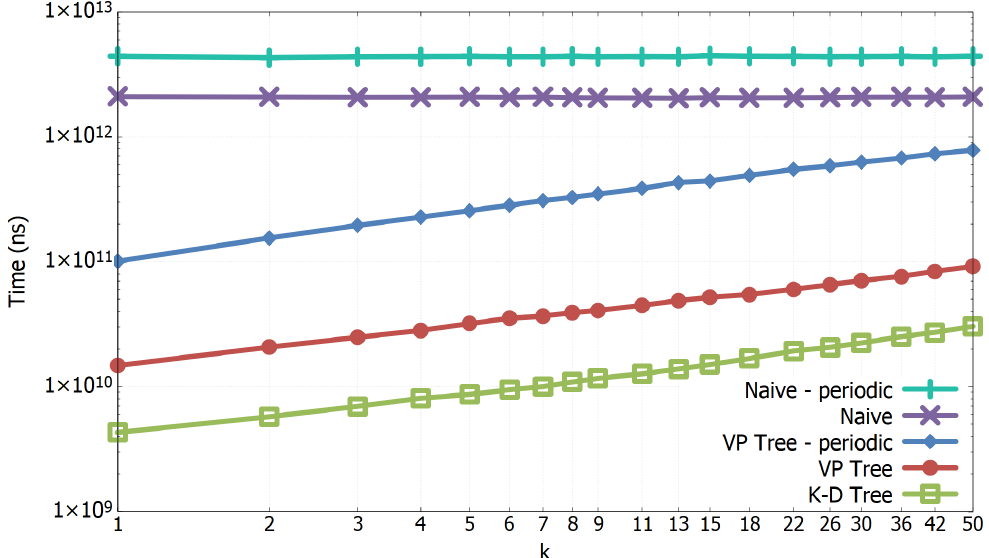
Figure 2. Computational times comparison of the all- k -nn algorithms as the size of the neighbourhood k grows. n = 100,000, d = 6, 1 ≤ k ≤ 50. Double logarithmic